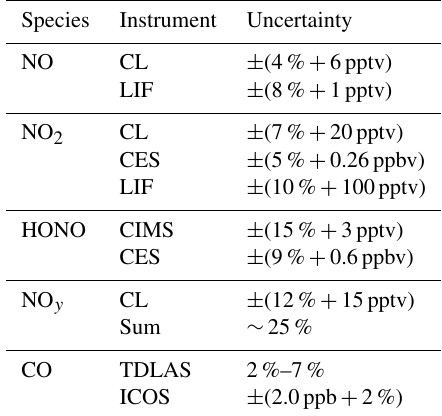
Table 1. List of measured species and instruments, including the corresponding uncertainties, during FIREX-AQ. For uncertainties given as ± ( x % ± y pptv), x represents the accuracy and y repre- sents the 2 σ precision in 1s. Species Instrument